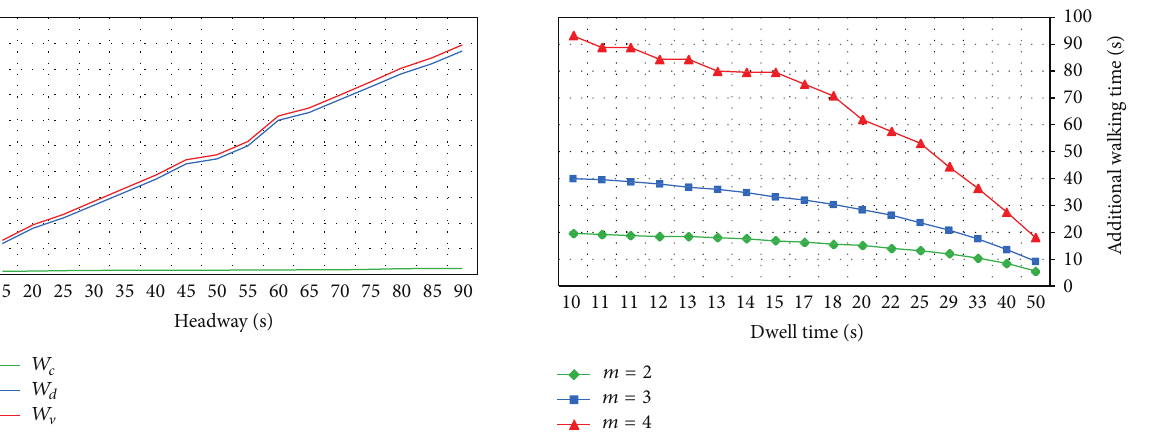
Figure 3: Average waiting time with different arrival rate of buses. Figure 4: Additional walking time at different dwell times for various berths, 𝜆 𝑏 = 0.025 veh/s.